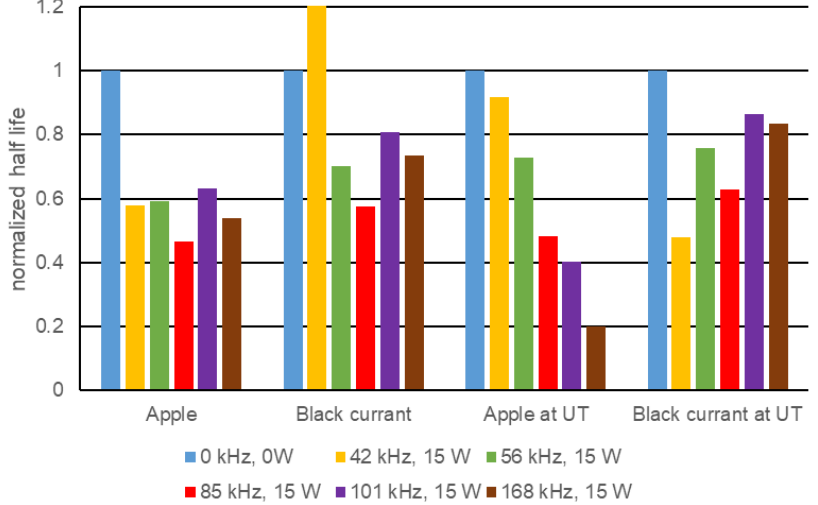
Figure 8. Normalized half-lives of the foams for all juices and frequencies related to reference half- lives (Apple: 5.5 s, black currant: 5.66 s, apple at UT: 8.77 s, black currant at UT: 4.5 s), n = 6.